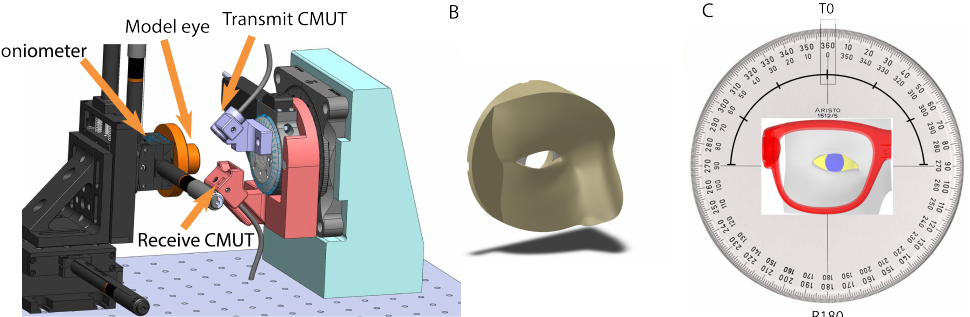
Figure 3. ( A ): CAD schema for the experimental bench-top setup and ( B ): occlusions ( C ). Transducer rotation. The receiver is fixed and the transmitter rotates around an arc. 30 degree steps are shown. We acquired data from − 90 to +90 degrees in 10 degree